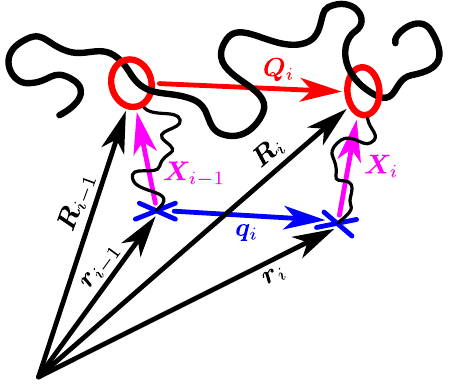
Figure 2. Sketch of proposed slip-link model on detailed level of description. The chain (thick black line) passes through slip-links (red circles) connected to affinely moving anchors (blue crosses) by virtual springs (thin black lines). Position vectors and connector vectors are indicated by black and colored arrows,